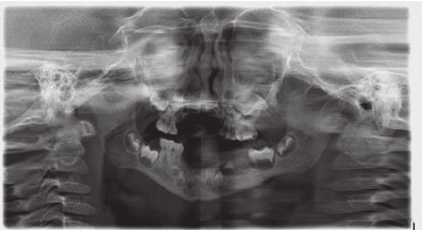
Figure 3: An orthopantomogram (OPG) taken at age of four, showing the maxilla and mandible with few standing deciduous teeth and maturation stage of permanent maxillary and mandibular